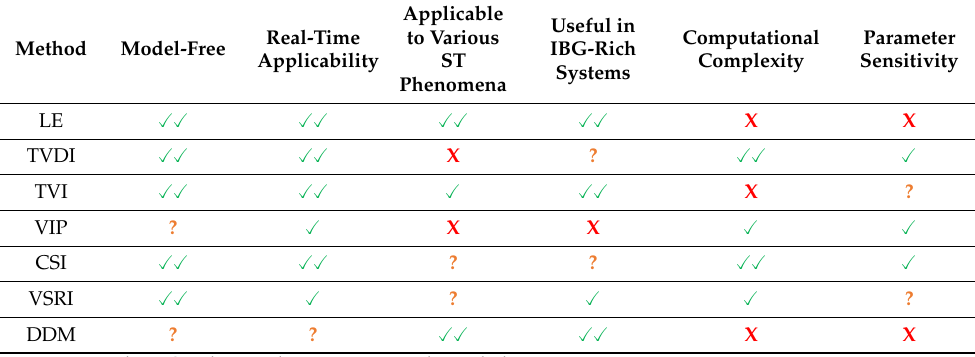
Table 2. Qualitative evaluation of the presented